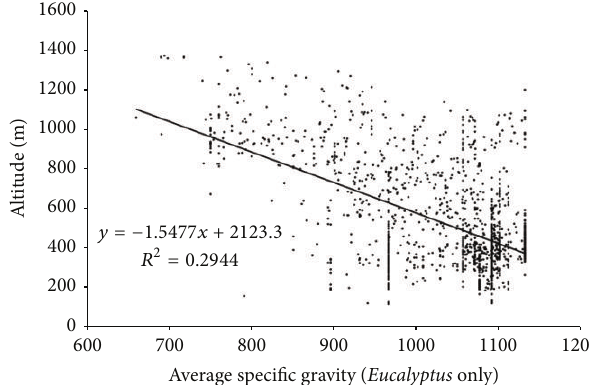
Figure4:Correlationintheaveragespecificgravityofall Eucalyptus for each plot against